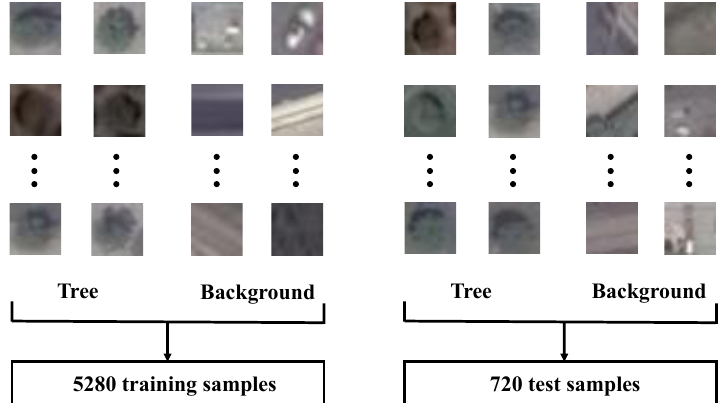
Figure 3. The composition of samples.